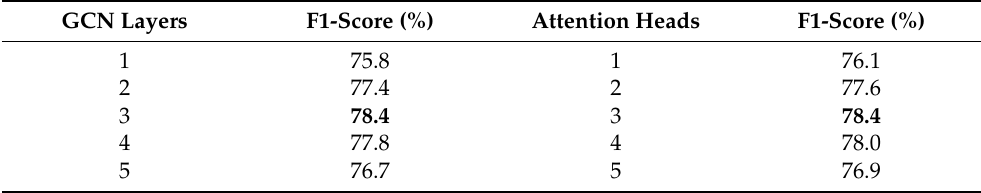
Table 4. Analysis of influence of GCN layers L and Attention heads K on model